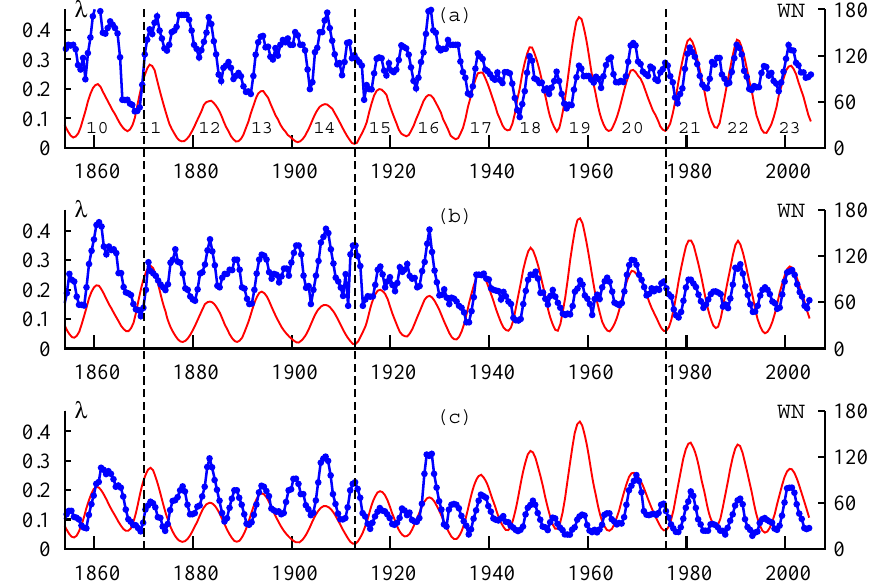
Figure 3. Blue curves : the irregularity index λ computed in 4-year sliding windows for the Wolf numbers averaged over N days; red curves : the Wolf numbers averaged over N days and then over 1461 days (4 years), where N is 162 (top panel), 324 (center panel), and 648 (bottom panel) days; m =2. Dashed black vertical lines are located at times of possible regime change of λ